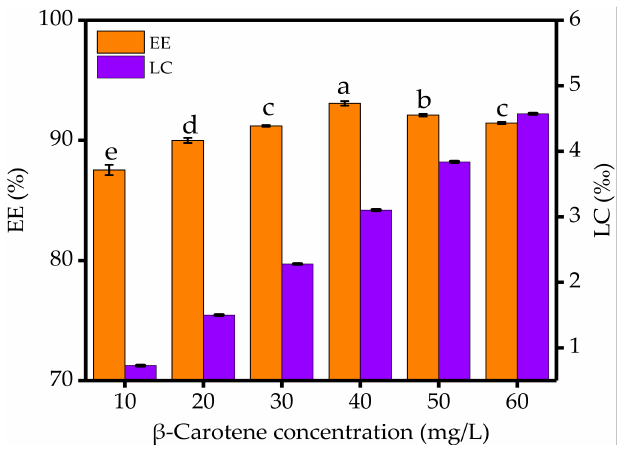
Figure 2. The EE and LC of SA-PEC-WPI stabilized emulsions at different β -carotene concentra- tions. EE: encapsulation efficiency; LC: loading capacity. The different letters within figure indicate significant differences ( p ≤